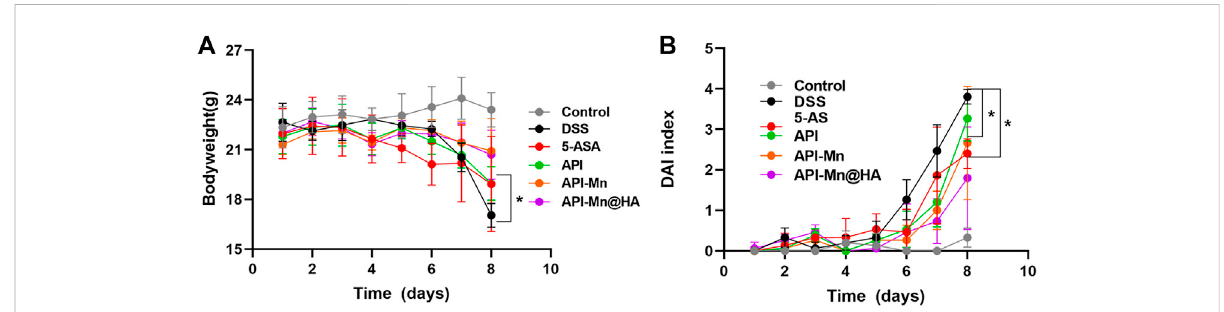
FIGURE 3 Effects of API manganese complex and API manganese complex coated with HA on physiological state of mice induced by DSS. (A) Curve of changes in DAI in mice. (B) . Curve of changes in bodyweight in mice. Data are shown as mean ± SD. n = 5, * p < 0.05, ** p < 0.01, *** p < 0.001 and **** p < 0.0001.